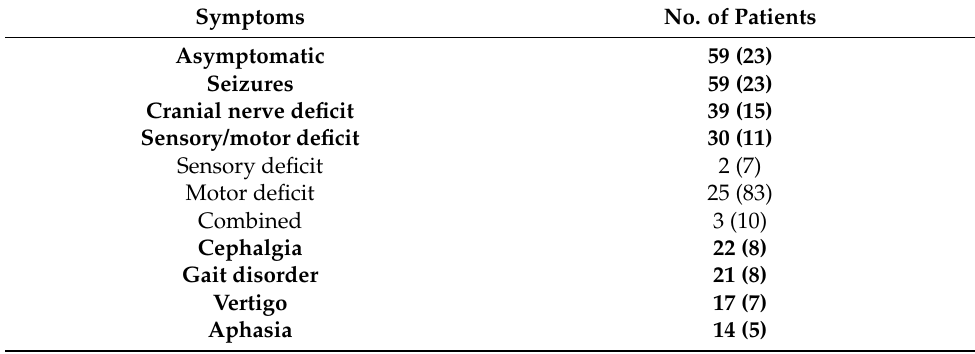
Table 2. Preoperative symptoms. Values represent number of patients unless otherwise indicated